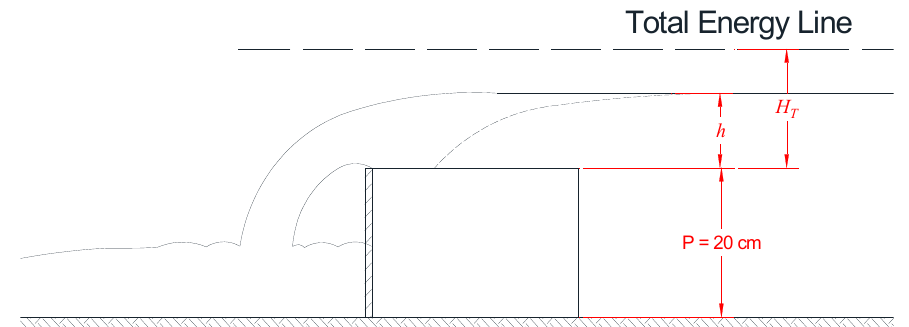
Figure 4. Schematic diagram of flow over rectangular labyrinth weir including flow parameters.